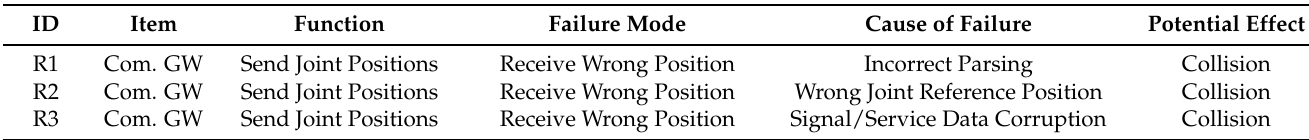
Table 7. Simplified SFMEA based on